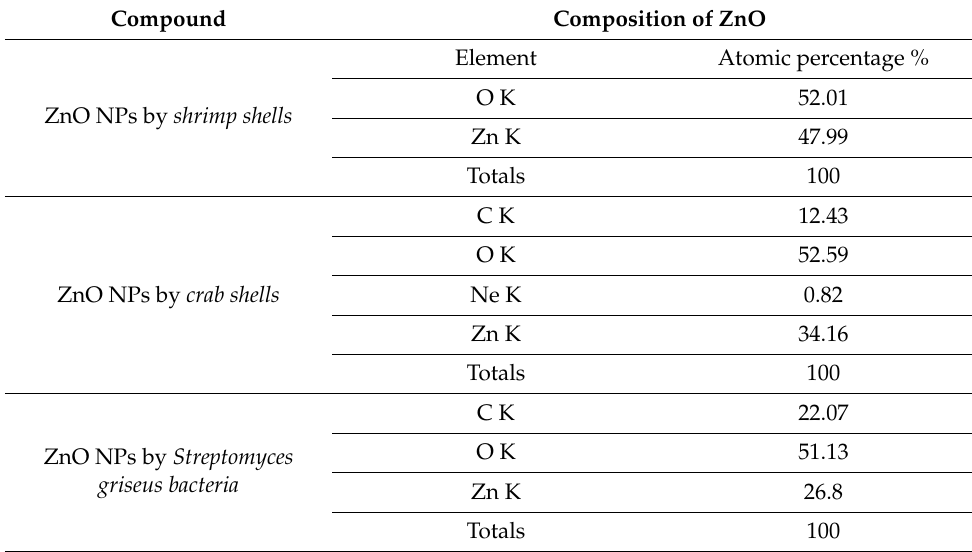
Figure 3. SEM-EDX image and particle size distributions of ZnO NPs from chitosan of ( a , b , g ) crab shells , ( c , d , h ) shrimp shells and ( e , f , i ) Streptomyces griseus bacteria . Table 2. The elemental composition of the ZnO NPs.